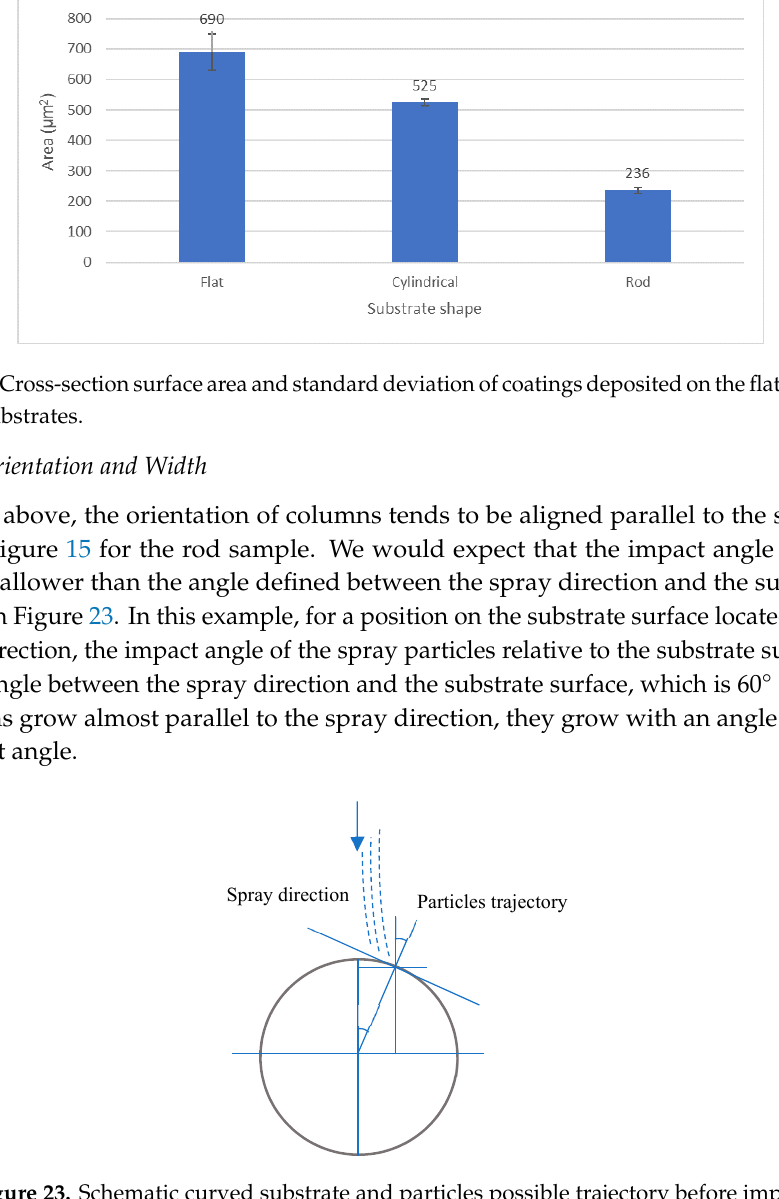
Figure 22. Cross-section surface area and standard deviation of coatings deposited on the flat, cylindrical and rod substrates.